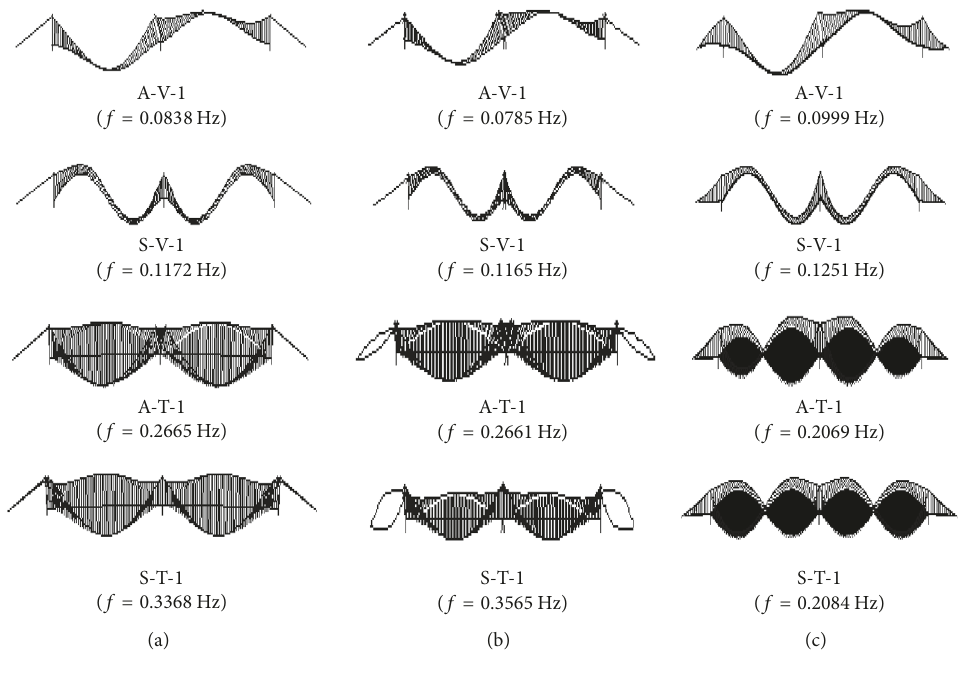
Figure 6: The primary structural dynamic properties of three bridges.